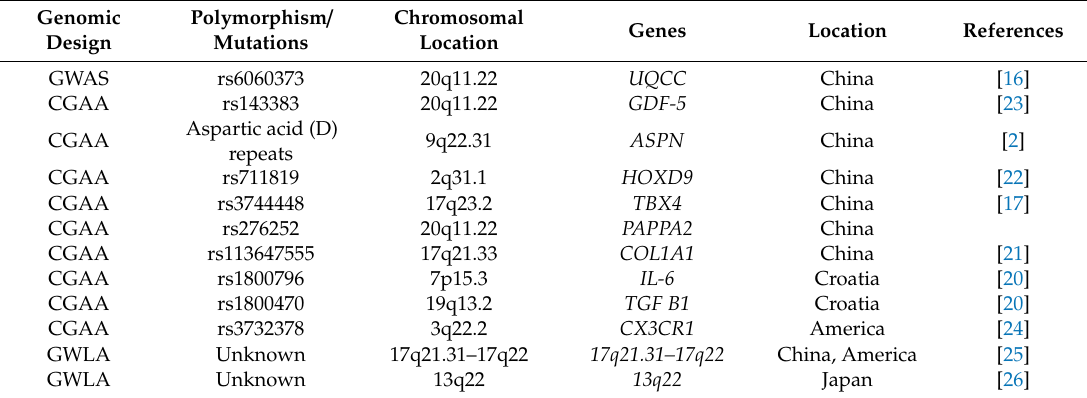
Table 1. List of the gene variants associated with